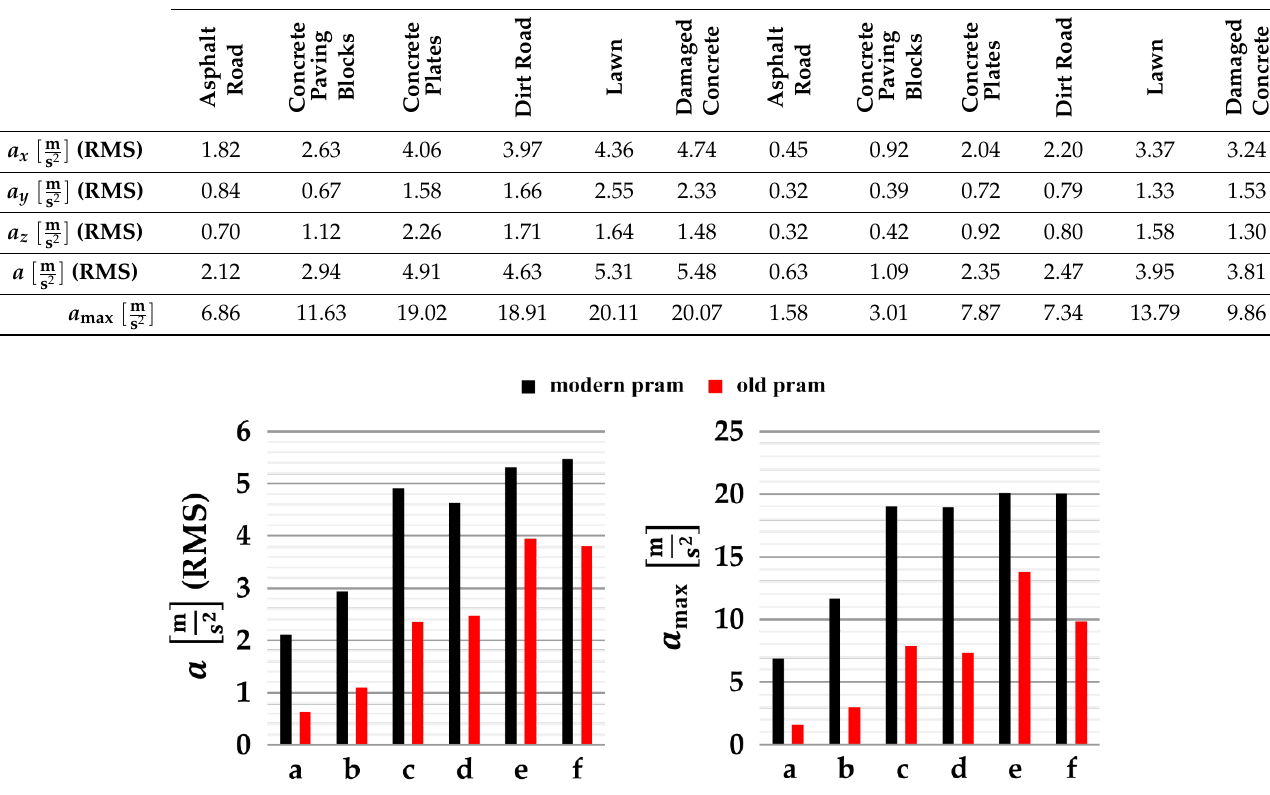
Figure 4. Comparative bar graphs of the RMS and maximum acceleration values from Table 2. As can be seen, at the same surface variants, both the point vibration total values ( 𝒂 ) and maximal values ( 𝒂 𝐦𝐚𝐱 ) were noticeably lower for the “old type” perambulator equipped with pneumatic tyres (old pram) in relation to the lightweight modern pram. The greatest difference can be found for the asphalt road (a): 70% lower point vibration total value and 77% lower maximal value. On average, their point vibration total value was 48% lower, and the maximal value was 59% lower for the old pram. Such a difference was most probably due to the lower weight of the modern pram and higher vibration transmissivity of both the frame and its polyurethane foam tyres.